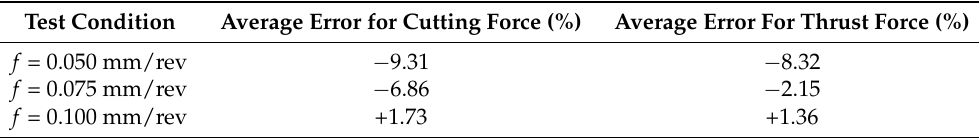
Figure 3. Comparison of the simulated (Sim.) and experimental (Exp.) force generation in Ti-phase cutting modeling [34,35] for different cutting speeds at feeds of 0.05, 0.075 and 0.100 mm/rev: ( a ) cutting force; ( b ) thrust force. Table 6. Average error between the simulated and experimental force generations in Figure 3.